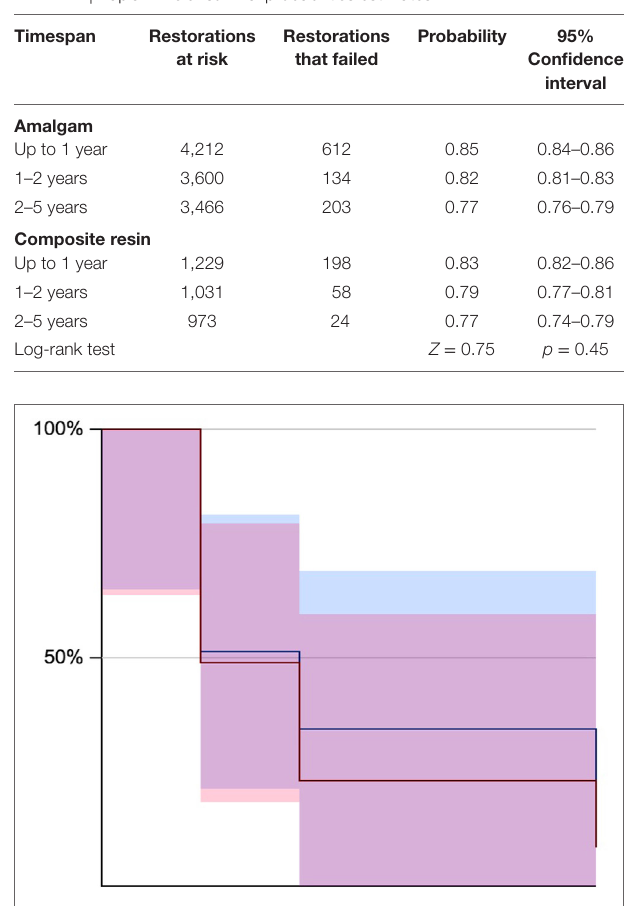
Table 2 | Kaplan–Meier survival probabilities estimates.